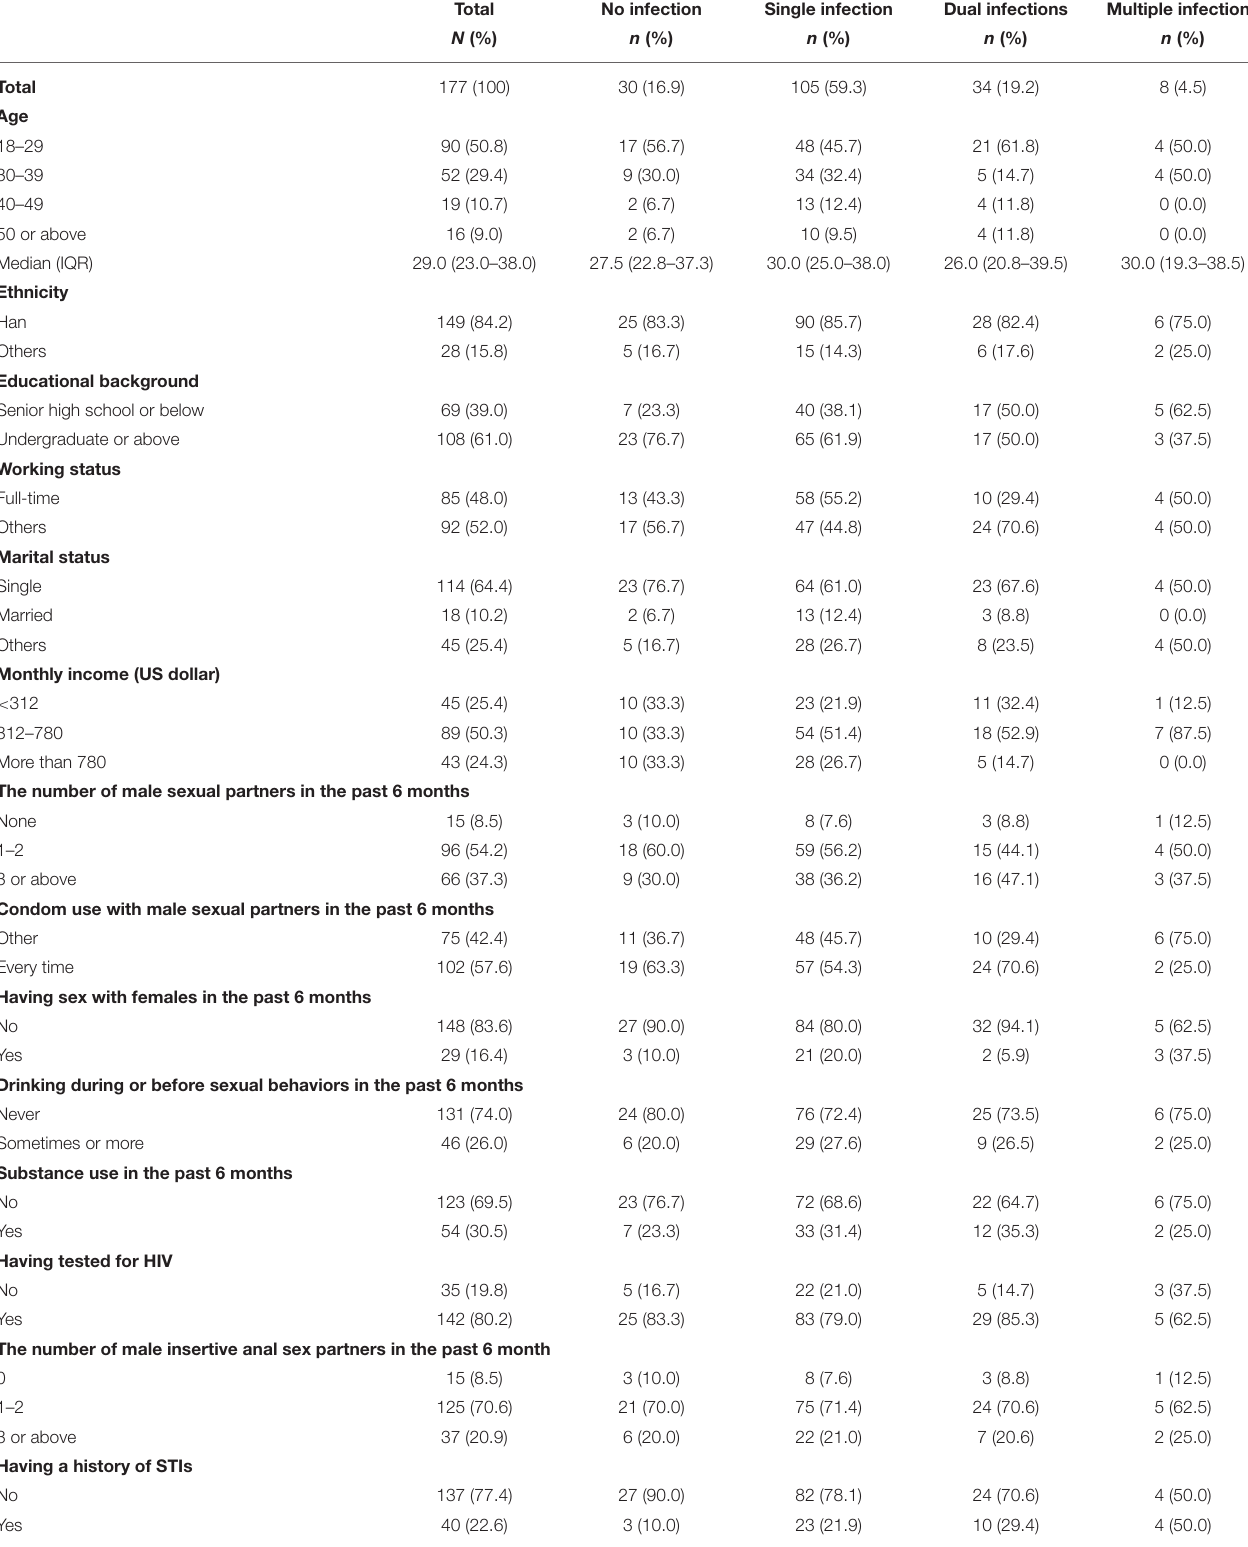
TABLE 1 | Demographic and behavioral characteristics among 177 MSM with no, single, dual, and multiple infection with STIs (HPV, CT, NG, TP). Total No infection Single infection Dual infections Multiple